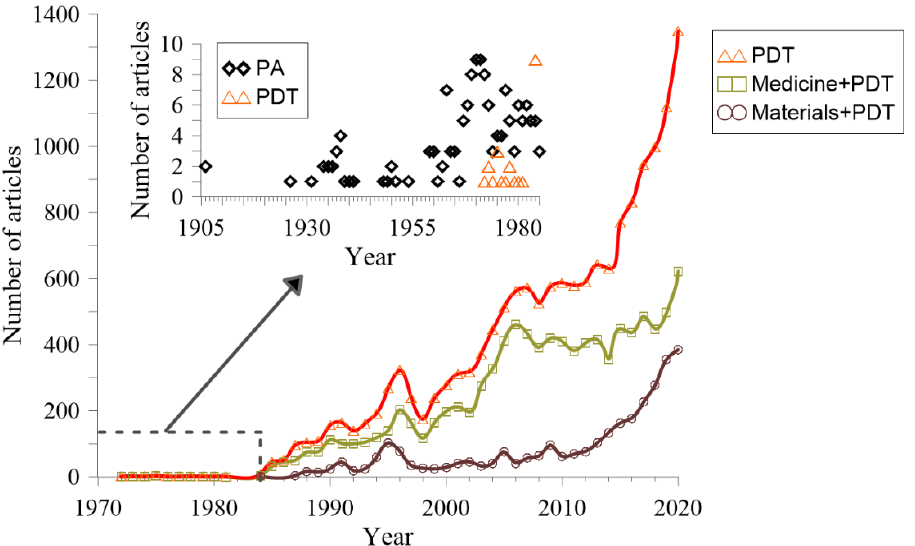
Figure 1. Number of articles per year as a result of the search in the Scopus database (Elsevier). The search was restricted to only the titles of the articles (not restricted to review articles). Queries for each line were: TITLE (“photodynamic therapy”) red line; TITLE (“photodynamic therapy”) AND SUBJAREA (MEDI) green line; TITLE (“photodynamic therapy”) AND SUBJAREA (MATE) purple line. Note that the subject area is overlapped in some journals (materials and medicine are selected because they are more differentiated). Inset shows the difference in articles between Photodynamic Action (PA, dark symbol) and Photodynamic Therapy (red symbol).